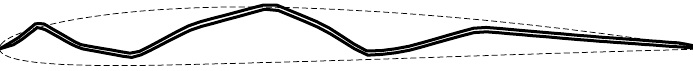
Figure 3. A corrugated airfoil and its envelope of NACA2408 airfoil.